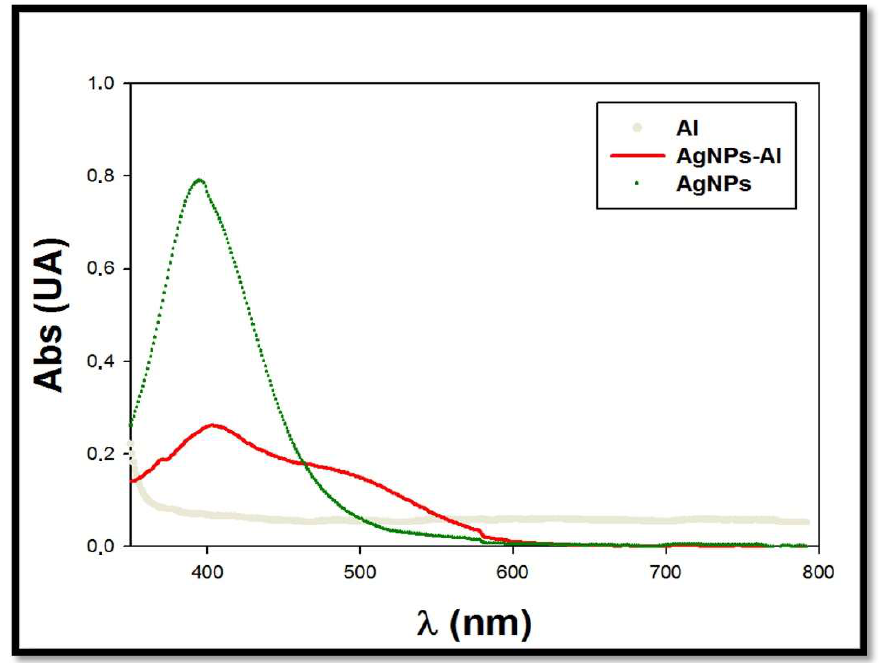
Figure 2. Spectra of the mixture citrate + PVP-AgNPs:Al. C Al(III) = 100 mM; C Citrate + PVP-AgNPs = 7.6 × 10 −15 M.